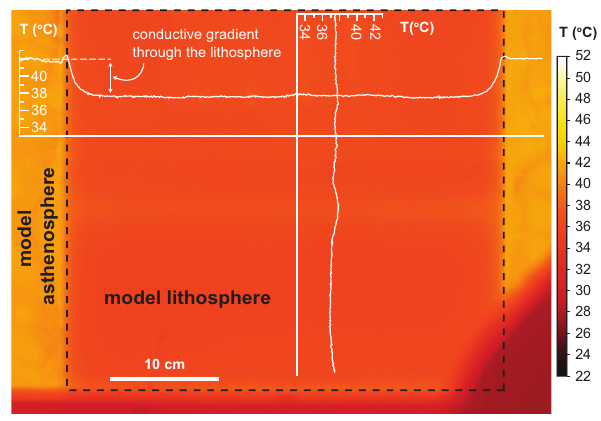
Fig. 6. Infrared image of the model surface. The homogeneity of the surface temperature T s is measured using an infrared camera. After 3 h of heating, the temperature field shows only one small ridge associated with the plate boundary. The temperature varia- tions across the model surface are otherwise smaller than 0.2 ◦ C. In this test the surface temperature was 38 ◦ C and the temperature of the asthenosphere was 42 ◦ C. In the bottom right darker corner, the model is